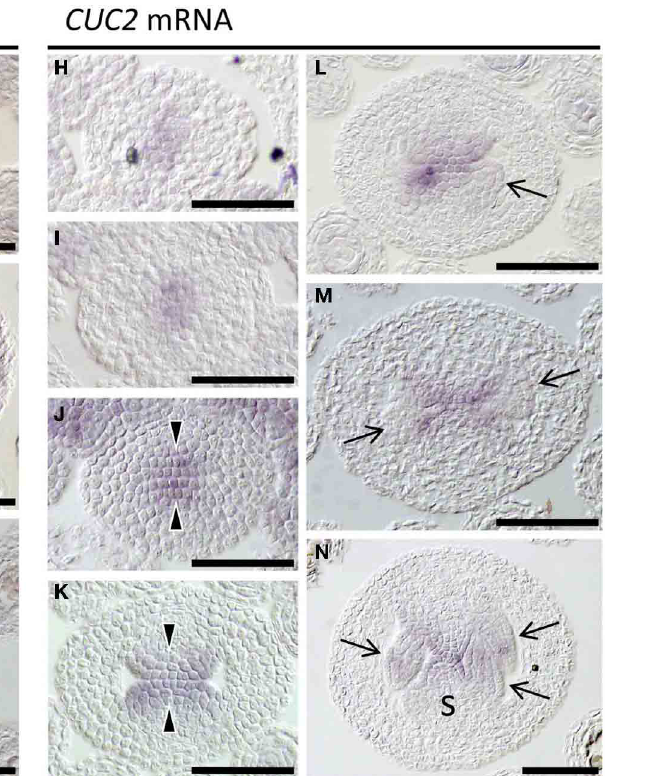
gynoecia at stage 6 (A,H) , stage 7 (B,I) , stage 8 (C,J) , early stage 9 (D,K) , mid stage 9 (E,L) , late stage 9 (F,M), and stage 10 (G,N) . Arrow, ovule; arrowhead, CMM; s, septum. Scale bars are 50 µ m.